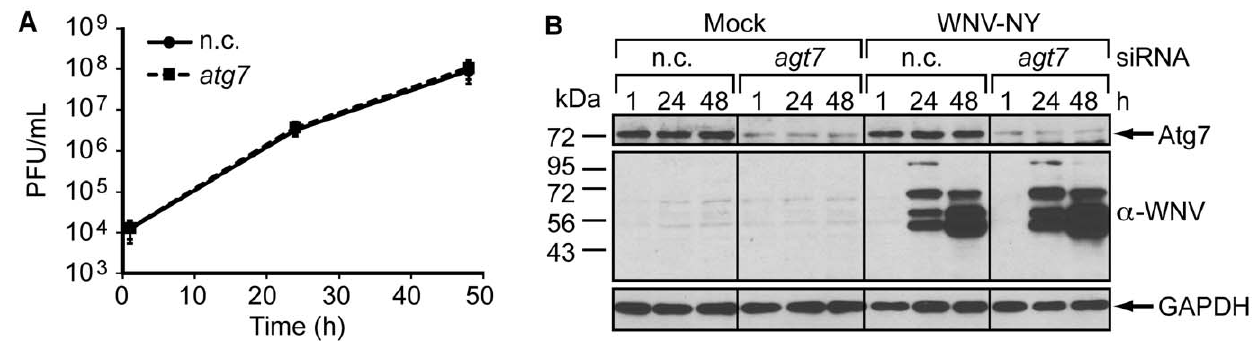
Figure 9. Autophagy does not influence WNV replication in 293T cells. (A) Infectious particle production in 293T cells following RNAi against atg7 . 293T monolayers transfected with non-coding (n.c.) siRNA or siRNA targeting atg7 were mock-infected or infected with WNV-NY (MOI=3). Culture supernatants were recovered at the indicated times (h) and the viral titers determined by plaque assay on Vero cells. Values represent the average ( 6 standard deviation) number of plaque-forming units (pfu) per mL from three independent experiments. (B) Immunoblot analysis of 293T cells following RNAi against atg7 . Whole cell lysates prepared from the cells in Panel A were subjected to immunoblot analysis for expression of Atg7 (top), WNV (middle) and GAPDH